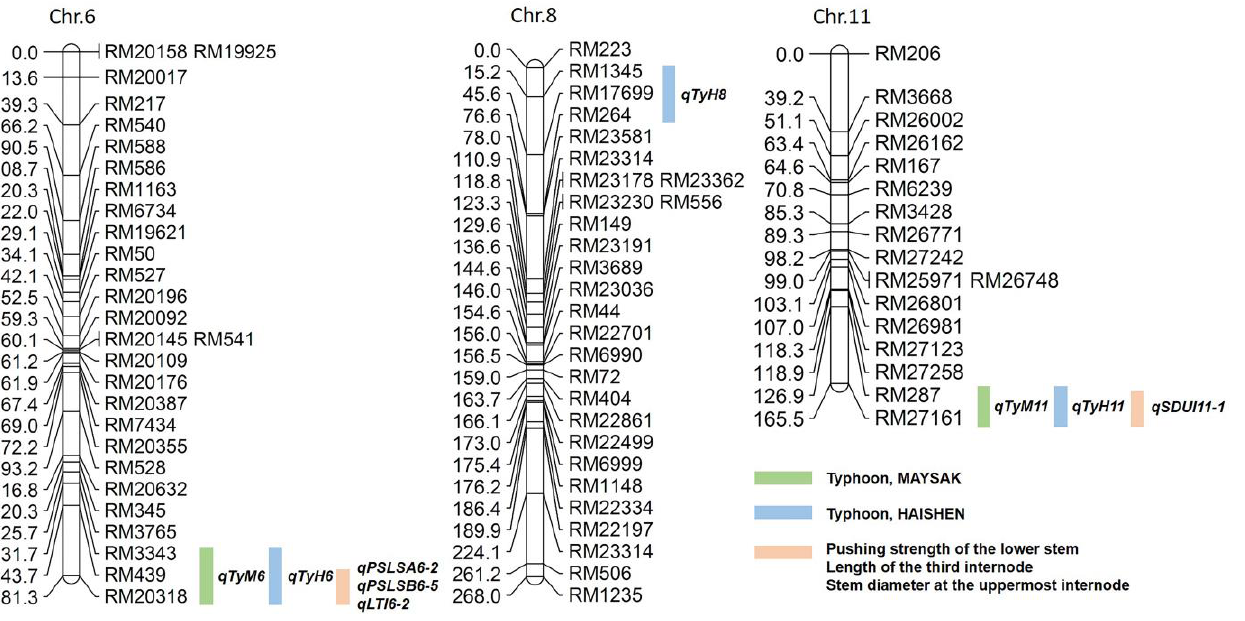
Figure 4. The LOD score and Gene Ontology (GO) annotation of the target QTLs are between RM3343 and RM20318. ( a ) LOD score of the QTL for resistance to lodging during typhoon Maysak and Haishen on chromosome 6 ( qTyM6 and qTYH6 ). ( b ) GO functional analysis of genes related to the target locus between RM3343 and RM20318. 2.3. Gene Exploration from Target QTL Marker Interval RM3343 – RM20318 Genes related to lodging resistance to typhoons within the marker interval RM3343 – RM20318 on chromosome 6 were filtered using the rice expression profile database and rice annotation project database. We screened 190 related genes in the target region RM3343 – RM20318 using gene annotation (Table S4). Furthermore, the functional classifi- cation of genes within the marker interval RM3343 – RM20318 on chromosome 6 in rice was predicted (Figure 4b) using the systems biology of AgriGO as a reference database.